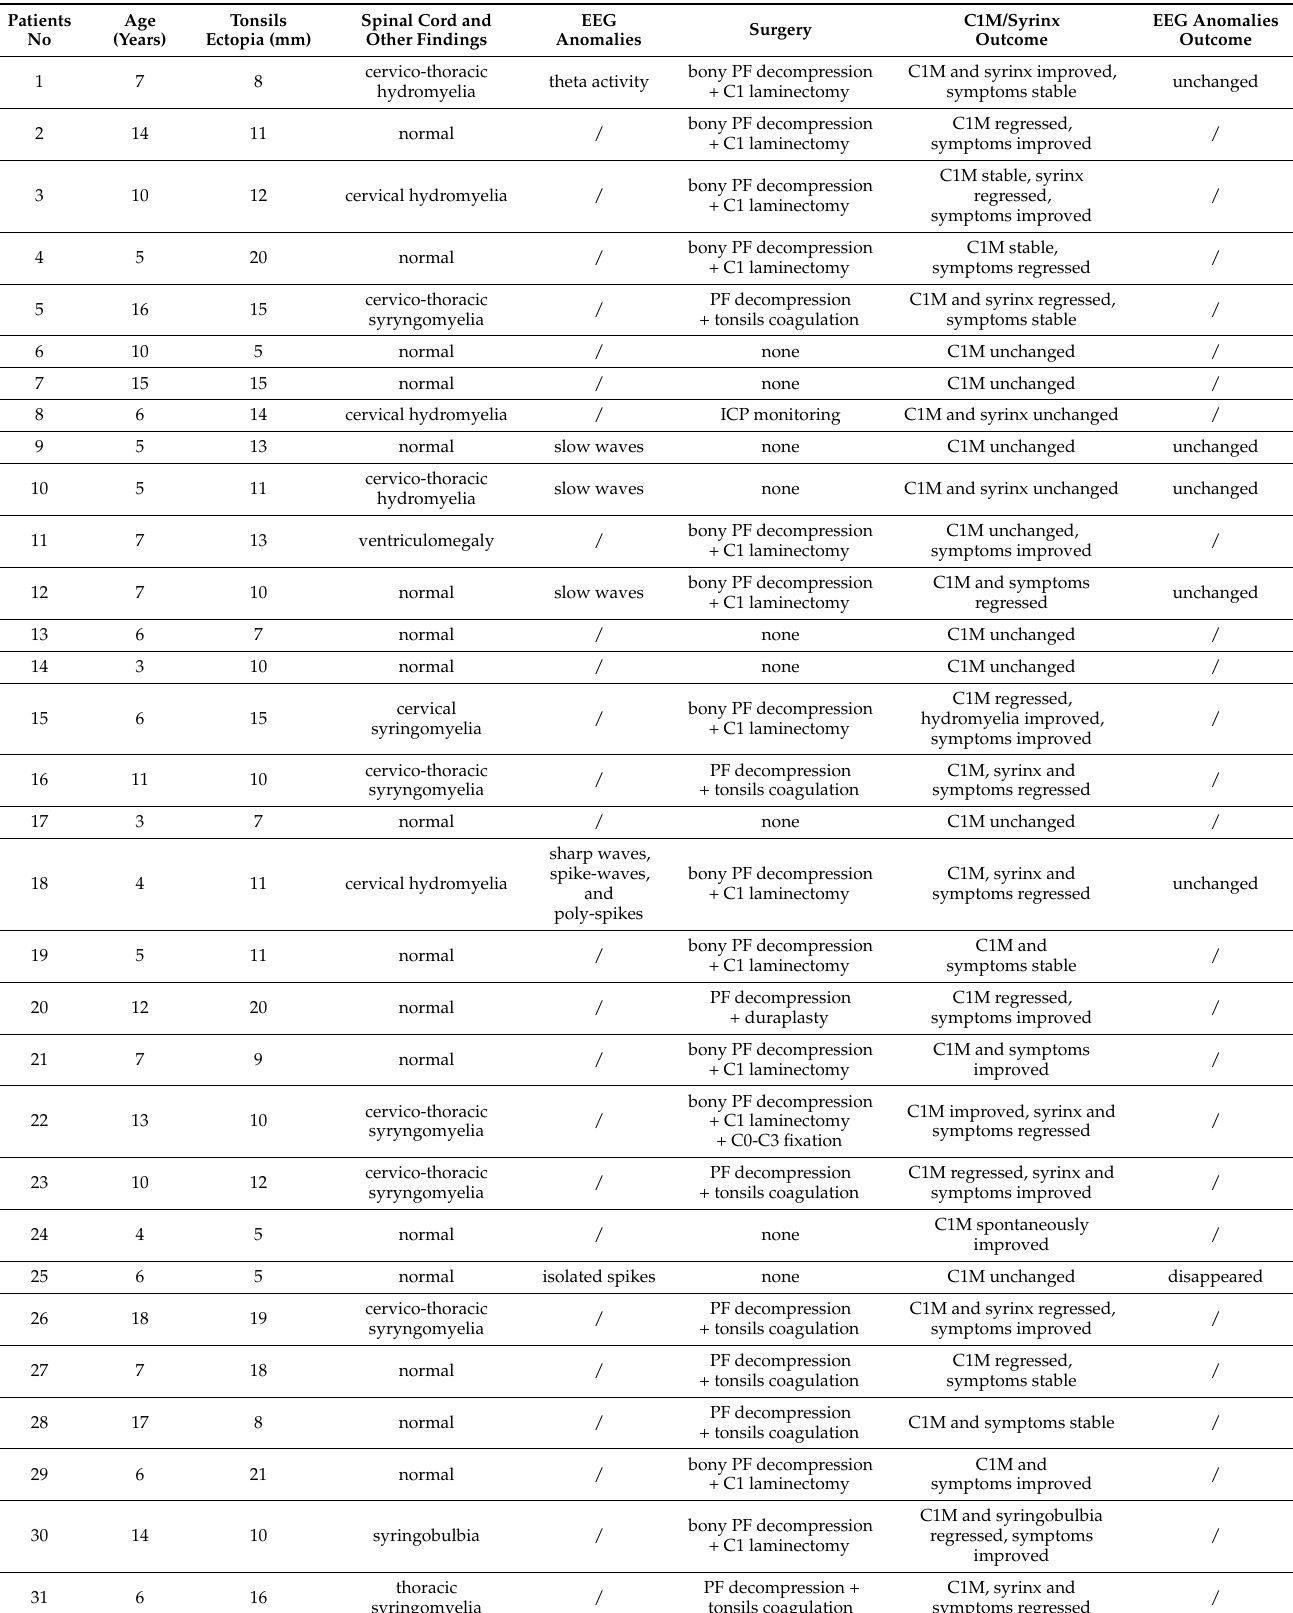
Table 4. Outcome of Group